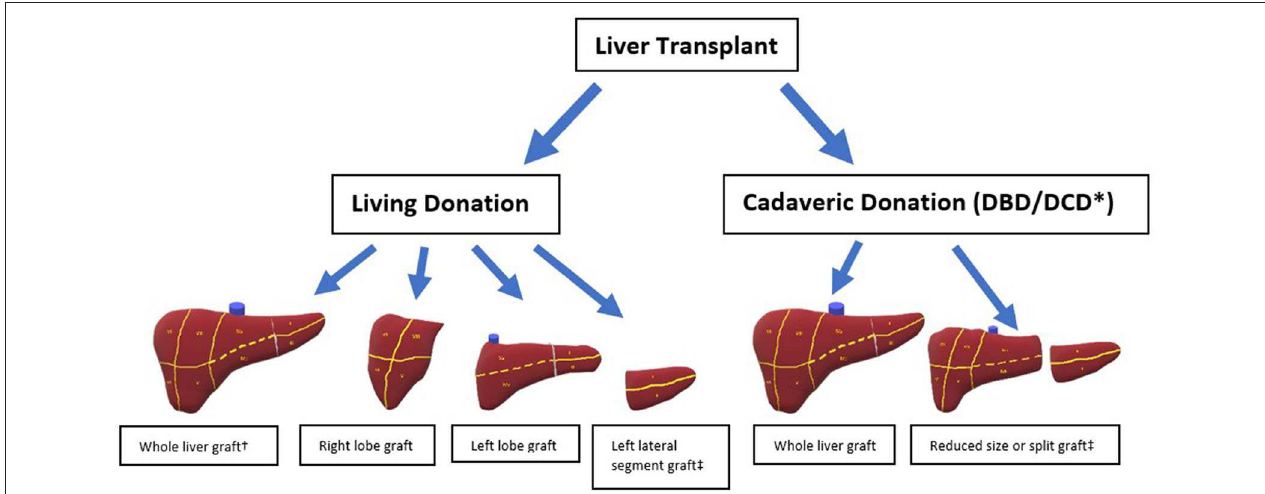
FIGURE 1 | Different types of liver allografts. * DCD grafts not split. † Living donation of whole liver only possible with domino transplantation. ‡ Either of these grafts is suitable for an auxiliary transplant.